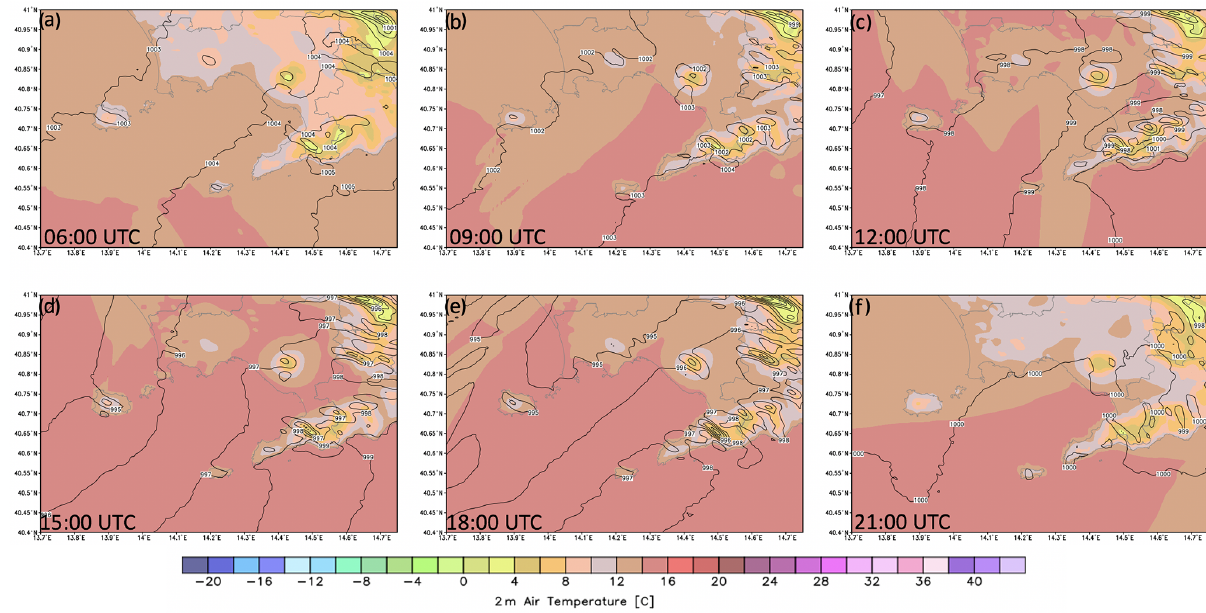
Figure 6. Sea level pressure and 2m air temperature simulated with the WRF model on 28 December 2020 at 06:00UTC (a) , 09:00UTC (b) ,